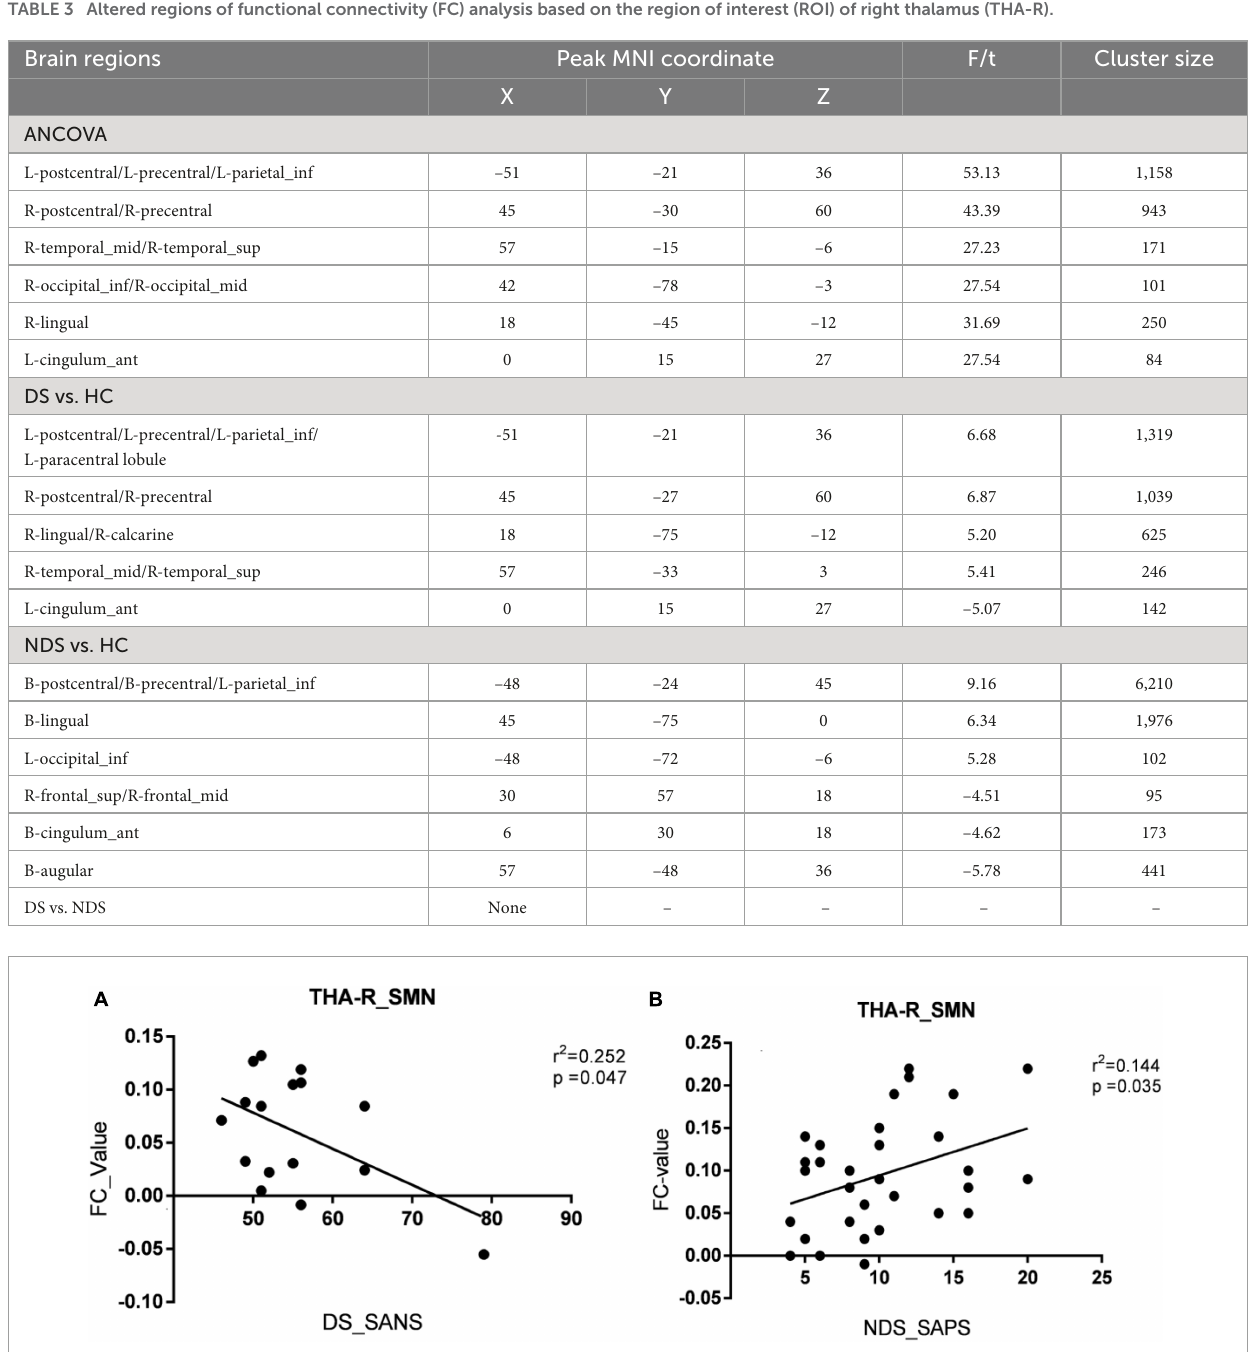
FIGURE5 The relationships between altered functional connectivity (FC) value of right thalamus (THA-R) with clinical symptoms. (A) The relationships between the FC value of THA.R and SMN with the Scale for the Assessment of Negative Symptoms (SANS) score in the deficient schizophrenia (DS) group. (B) The relationships between the FC value of THA.R and SMN with the Scale for the Assessment of Positive Sympt (SAPS) score in the non-deficient schizophrenia (NDS) group. The significance threshold was set at p < 0.05. SMN, sensory motor network. THA-R_SMN, FC of right thalamus and the sensory-motor network; DS_SANS, scoring on the SANS in the DS group; NDS_SAPS, scoring on the SAPS in the NDS group.